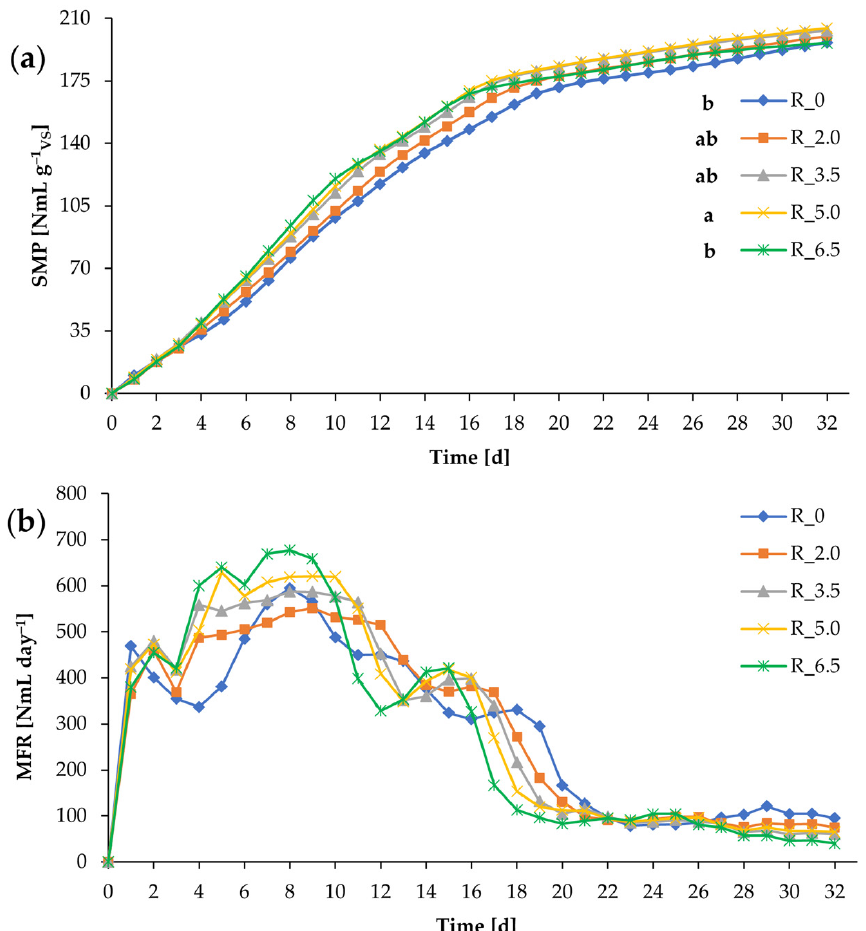
Figure 3. Impact of CNT addition on SMP ( a ) and MFR ( b ) during the anaerobic digestion of chicken manure (second batch of chicken manure). Different concentrations of CNTs (2.0 g L − 1 , 3.5 g L − 1 , 5.0 g L − 1 , and 6.5 g L − 1 ) were added to the reactors (R_2.0, R_3.5, R_5.0, and R_6.5, respectively). R_0 operated without addition of CNTs. Values at day 32 (SMP) were statistically compared; a,b arith- metic means (averages) that do not share a letter are statistically significantly different from each other according to the Tukey method and 95% confidence.